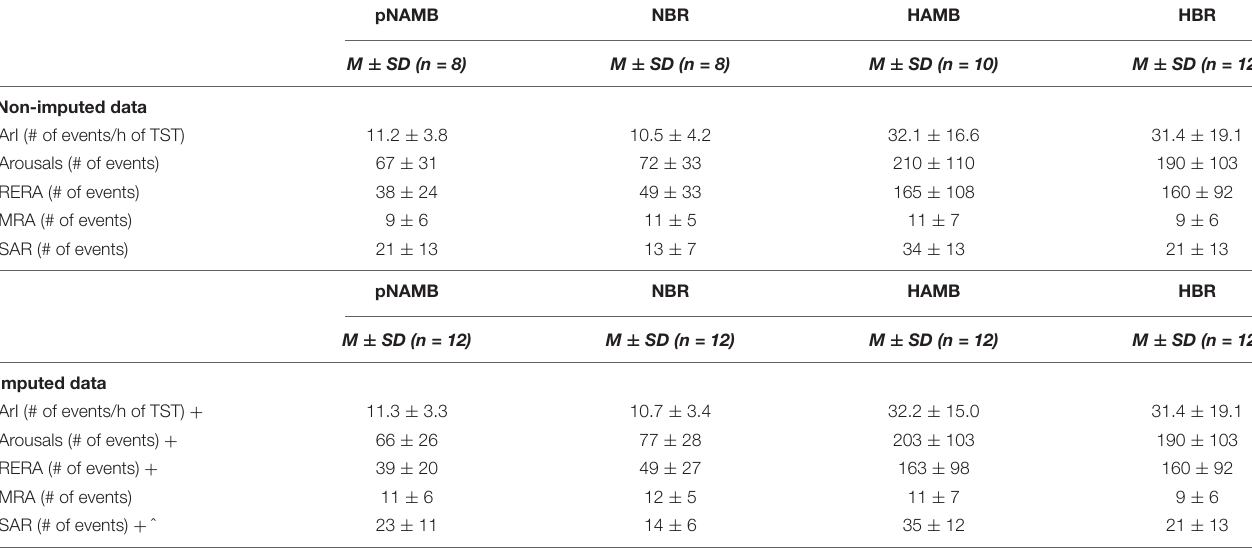
TABLE 3 | Overview of sleep fragmentation outcomes in each level of both independent variables (i.e., activity and PO 2 ). pNAMB NBR HAMB HBR M ± SD (n = 8) M ± SD (n = 8) M ± SD (n = 10) M ± SD (n =